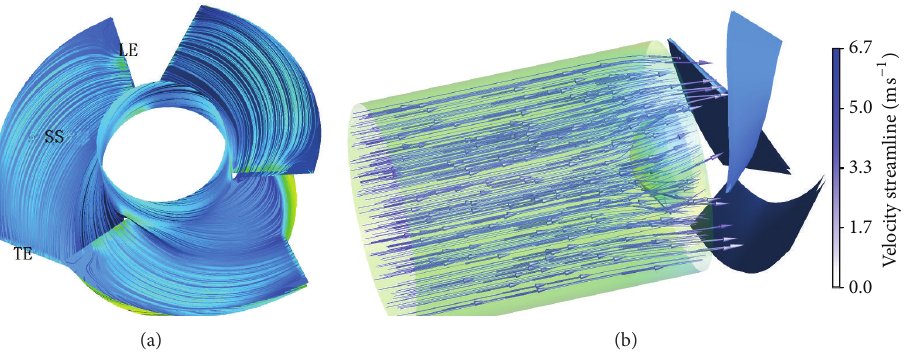
Figure 11: Velocity streamlines of the pump without tip clearance at 0.75 𝑄